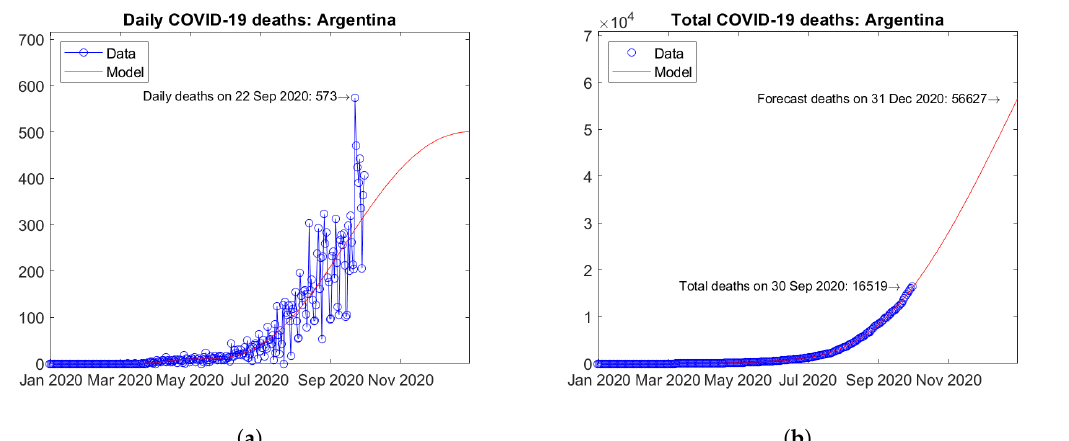
Figure 24. Actual and predicted trends in Argentina: ( a ) daily deaths, ( b ) total deaths.